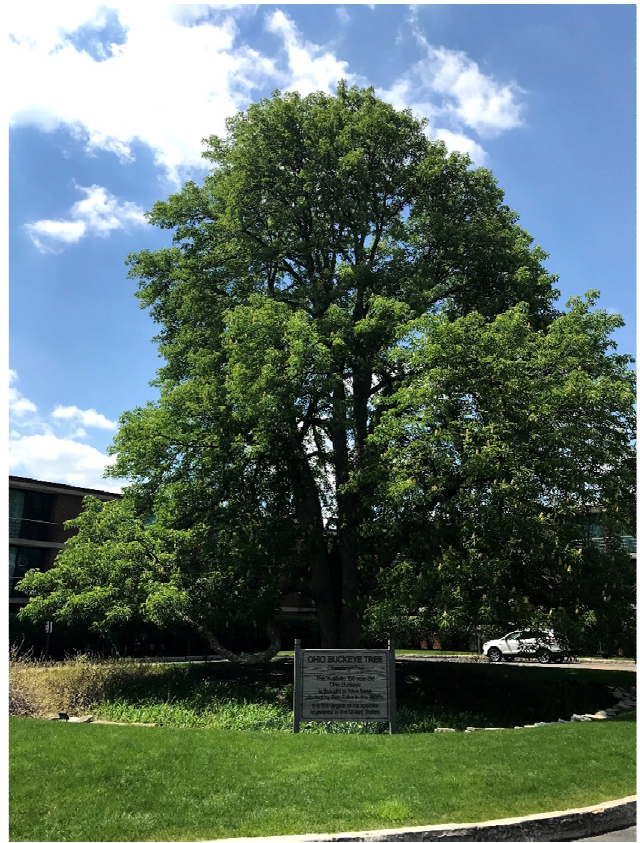
Figure 1. US National Champion Ohio Buckeye Tree, Aesculus glabra , DuPage Co. IL. Photo by M.V.A. taken in May, 2019.